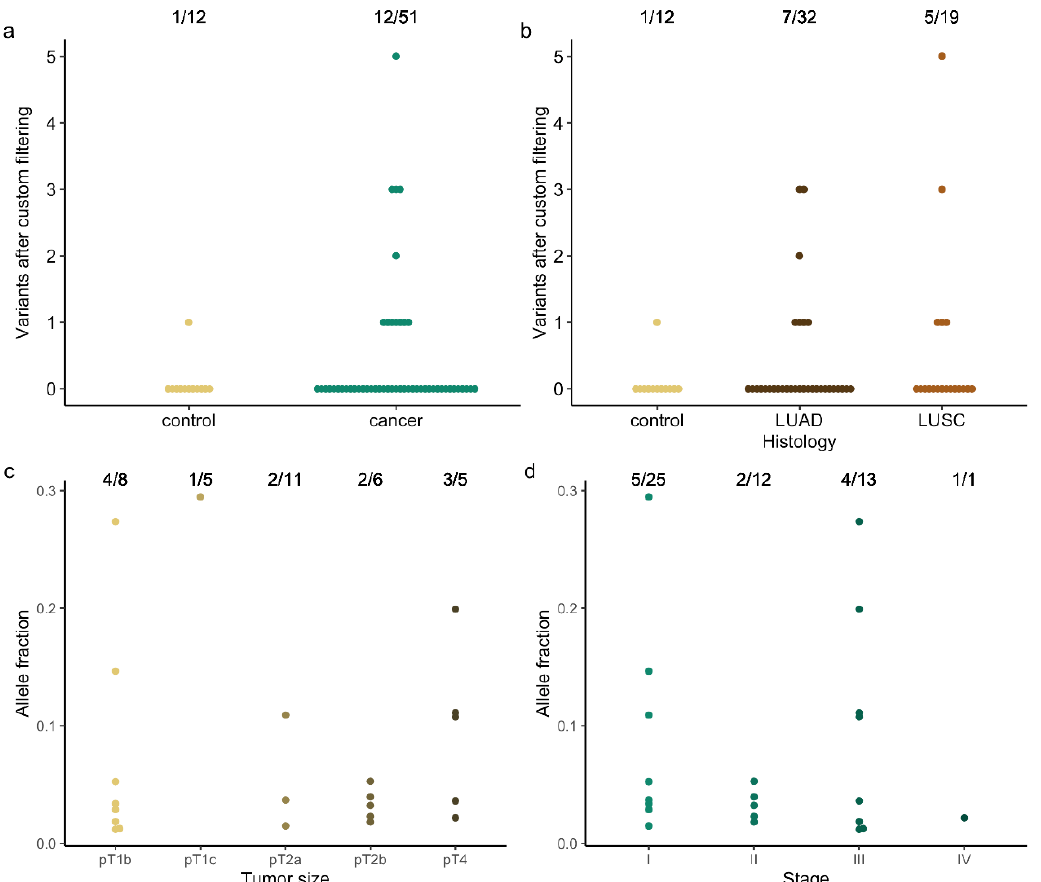
Figure 2. Somatic variant detection in control and cancer patients ( a , b ) and correlation with disease stage ( c , d ). ( a ) Overall somatic variant detection in control (yellow) and cancer (green) patients. Dots represent the number of somatic variants reported for a sample. The detection rate is given at the top. ( b ) Same as ( a ) but according to adenocarcinoma (LUAD in dark brown) and squamous cell carcinoma (LUSC in light brown) histological subtype. ( c ) Variant allele fractions and detection rate according to tumor size, and ( d ) disease